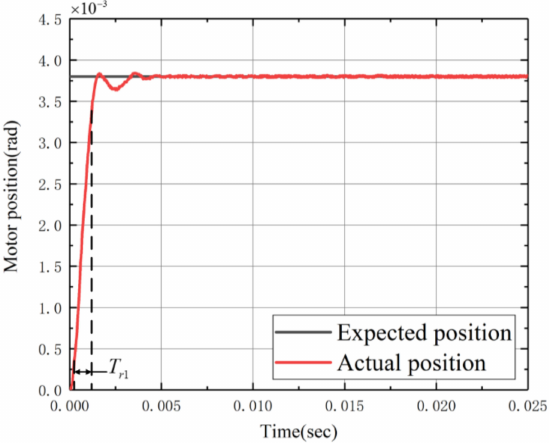
Figure 4. Step-responses in 1% of the whole stroke (0.0038